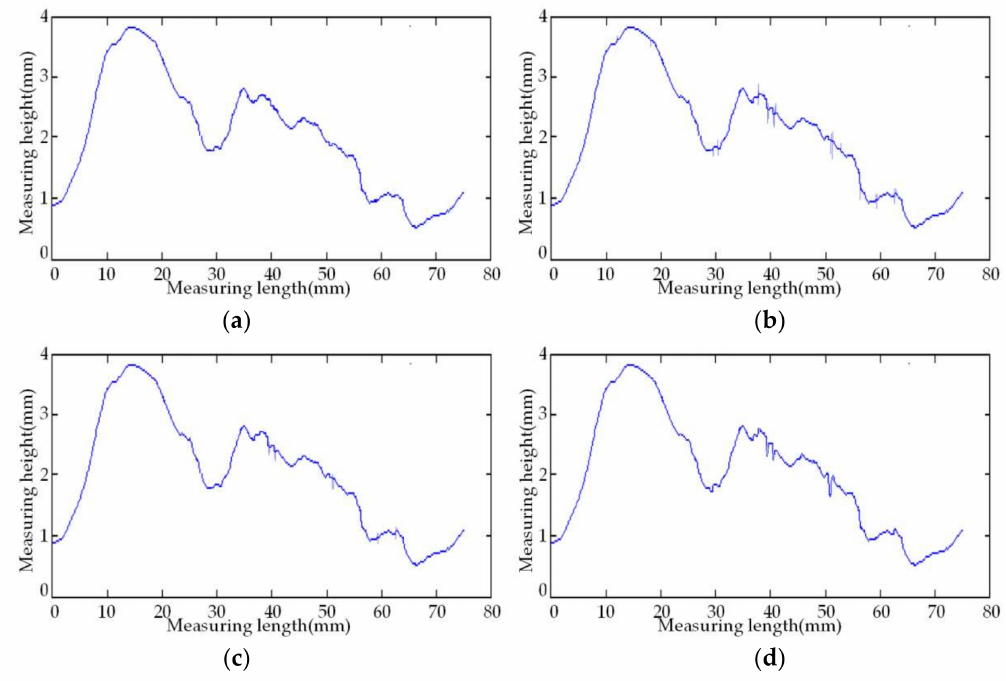
Figure 11. The effect comparison of different threshold functions in data denoising. ( a ) The soft threshold function; ( b ) the hard threshold function; ( c ) the improved threshold function in reference [26]; ( d ) the new threshold function in this